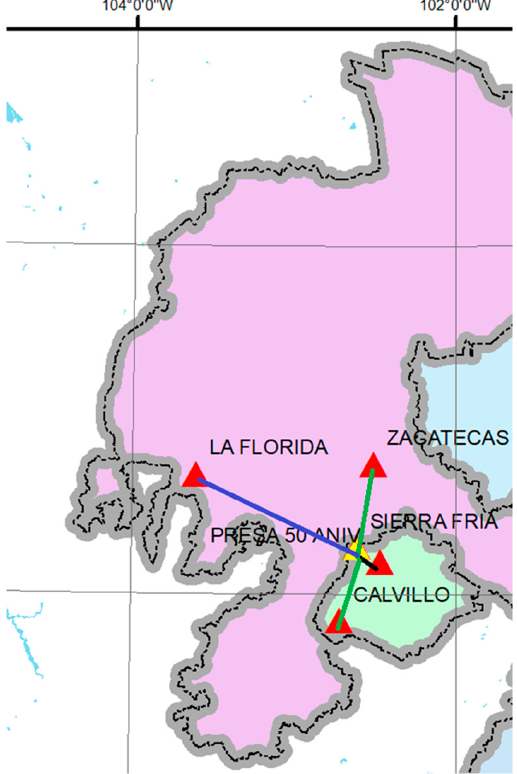
Figure 8. How kriging works.